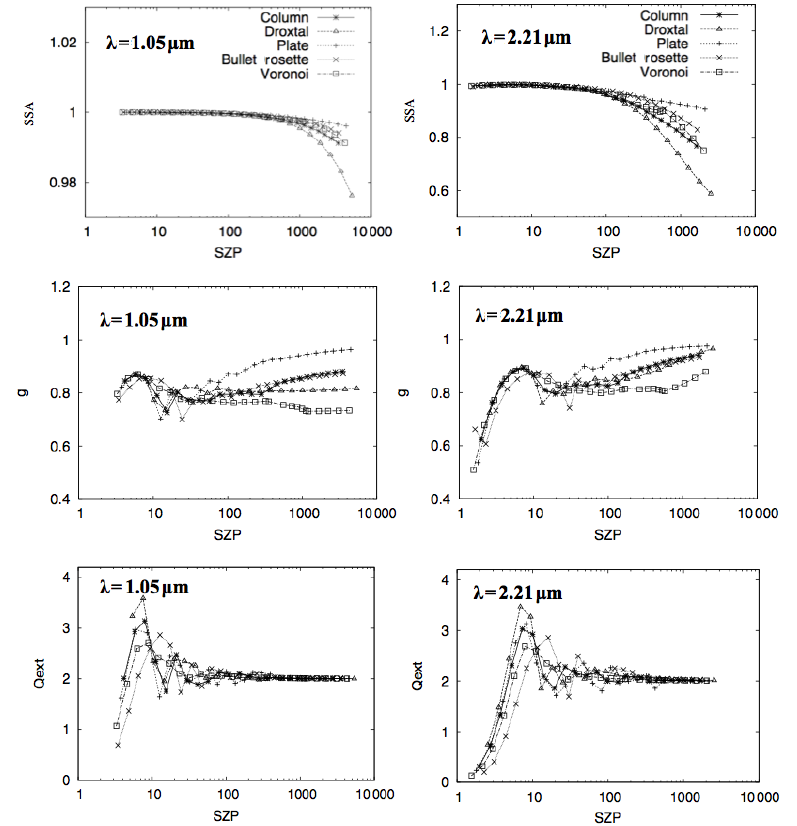
Figure 4. Comparison of the single-scattering property of the various ice crystals models computed in this study at wavelength of 1.05 and 2.21µm (SSA: single-scattering albedo; g : asymmetry factor; Q ext : extinction